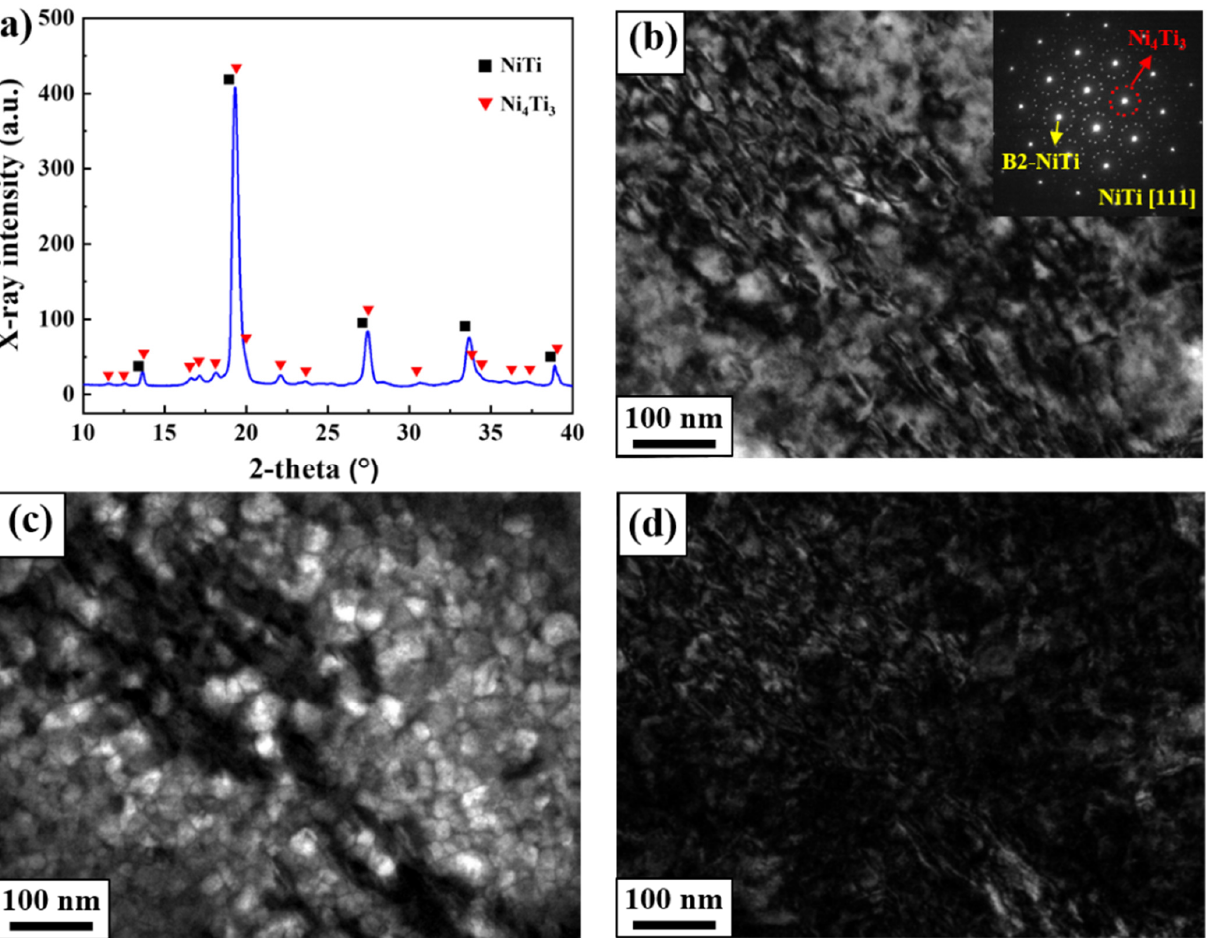
Figure 5. Microstructural analysis of the well-established SLM 60NiTi fabricated by P = 80 W and v = 350 mm/s. ( a ) XRD pattern and phase identification; ( b ) bright-field image and corresponding selected area electron diffraction (SAED) pattern; ( c ) dark-field image of the Ni 4 Ti 3 phase; ( d ) dark- field image of the B2-NiTi phase.